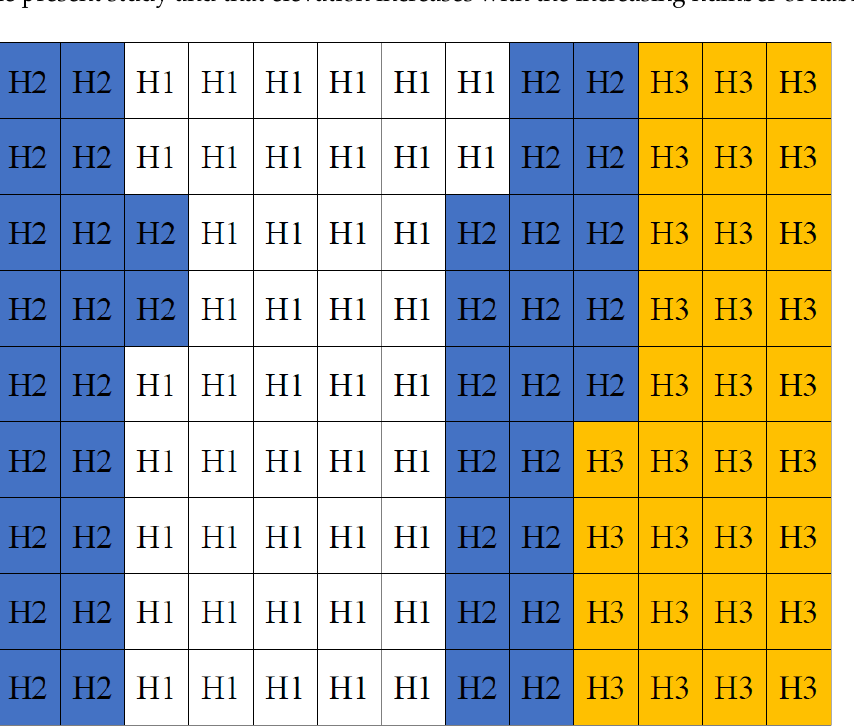
Figure 2. Habitat categories of the 5-ha forest plot at 20 m × 20 m scale. The white represents low-valleys (H1), the blue represents mid-hillsides (H2), and the yellow represents high-ridges (H3).